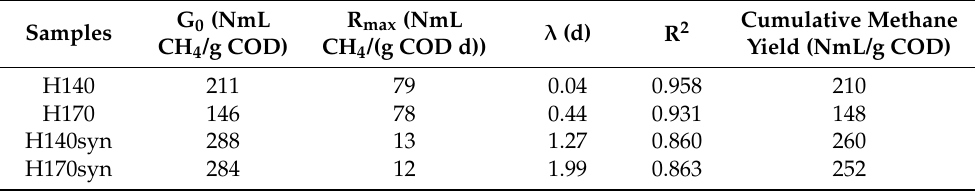
Table 5. Model parameters by the modified Gompertz model from cumulative methane production.